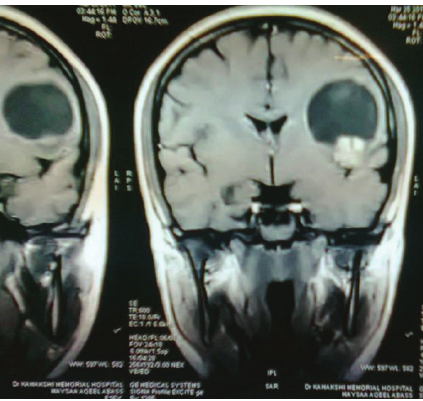
Figure 1: Plain MRI—coronal section showing lesion in the left frontoparietal region.